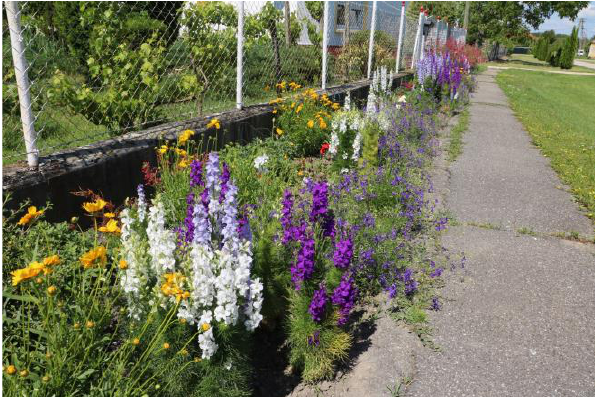
Figure 4. Delphinium consolida and Delphinium ajacis L. in a street garden (Markotabödöge, NW Hungary, 2020. Photograph by Gyula Pinke).